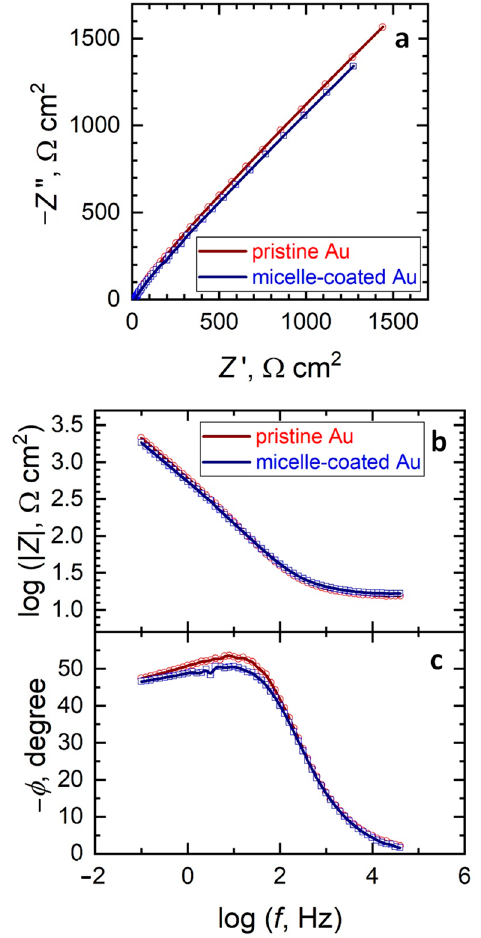
Figure 4. ( a ) Nyquist and ( b , c ) Bode diagrams of the impedance spectra of pristine and micelle- modified gold in 0.1 M KCl + 1 mM ferrocenemethanol. The solid lines and the discrete points correspond to the fitted and the measured data, respectively.